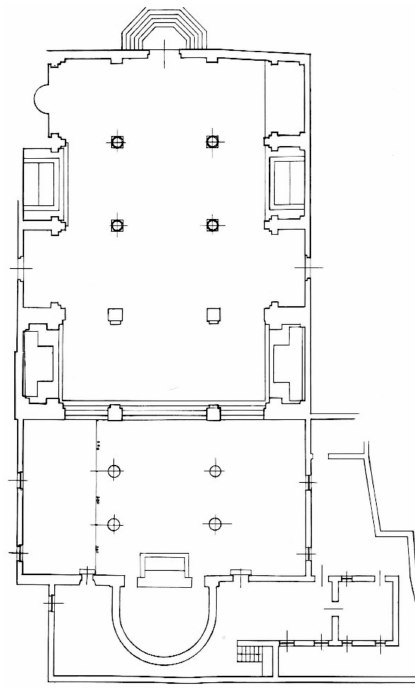
Figure 11. The contemporary Dome